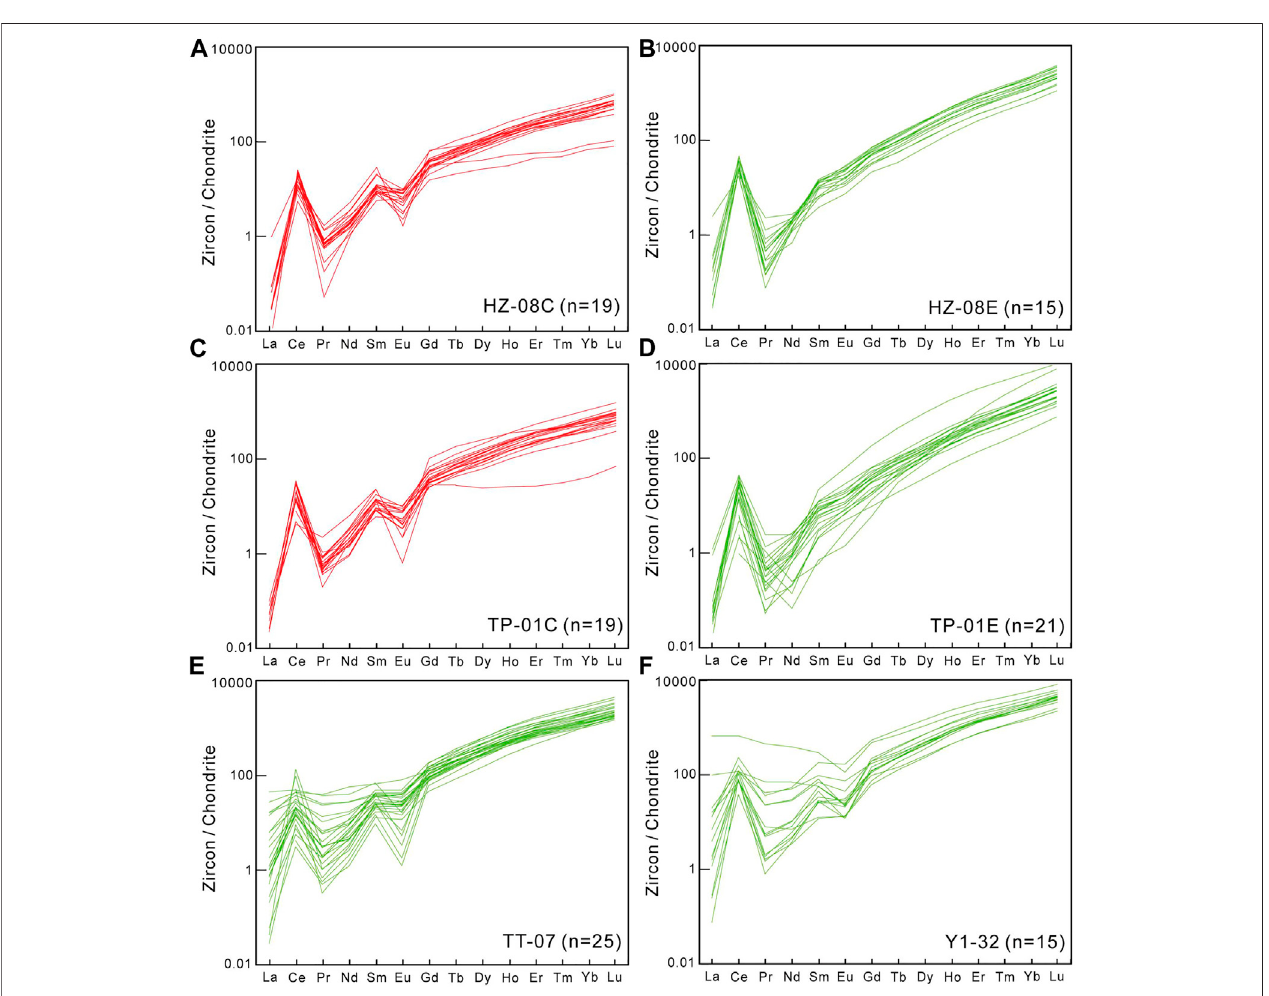
FIGURE6| Chondrite-normalizedzirconREEpatternsfortheHuaibei-Linhuanintrusiverocksamples:ChondritenormalizingvaluesarefromSunandMcDonough (1989).